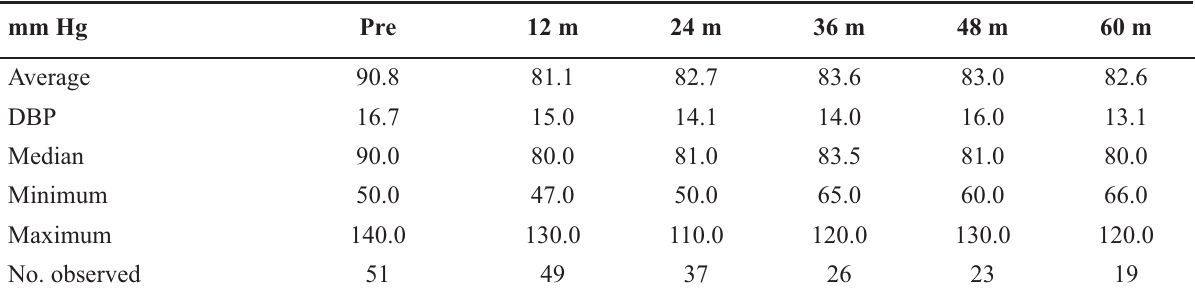
Table 3 – Averages of the diastolic blood pressures (DBP) from the pre-operative period until 60 months pos-nephrec- tomy.